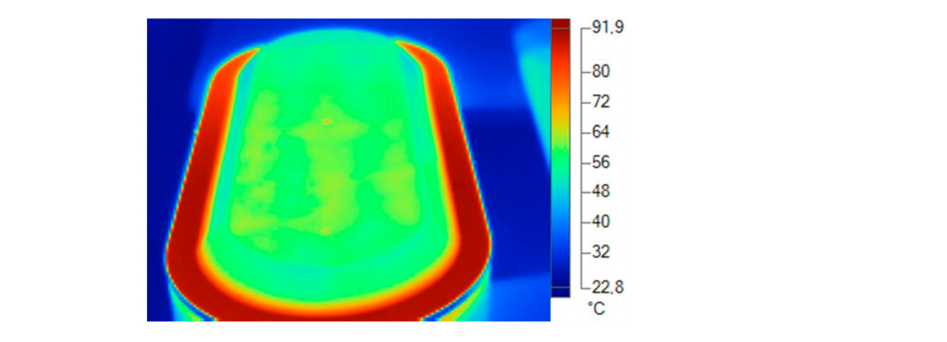
Figure 21. Thermal data of the heatsink. Reddish area: emissivity aluminum alloy 0.5. Source: Software SmartView 4.1 Fluke.